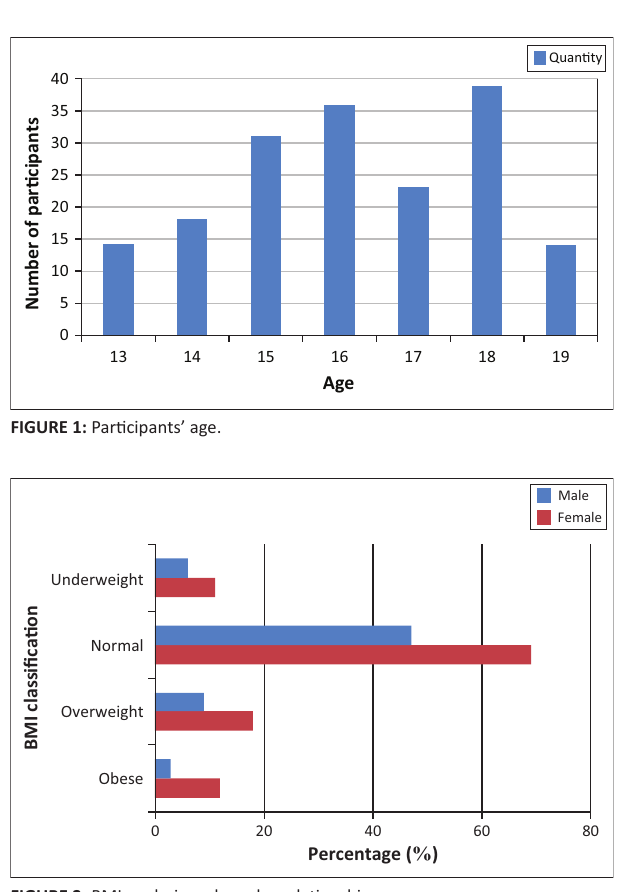
FIGURE 2: BMI analysis and gender